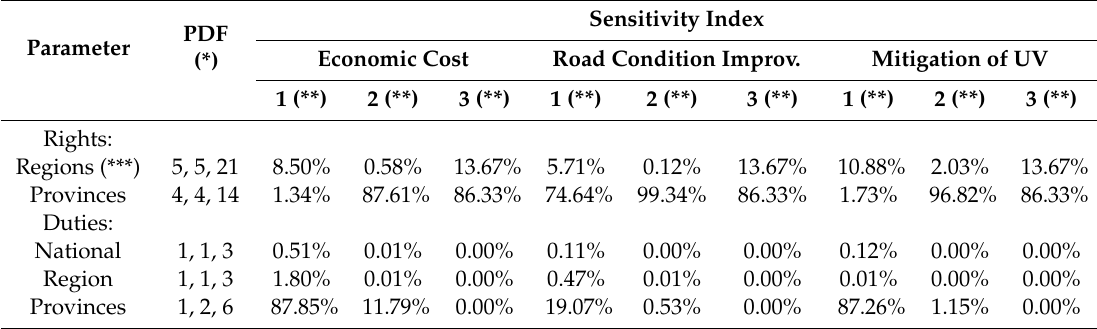
Table 3. Results of the global sensitivity analysis of the decentralization model parameters.